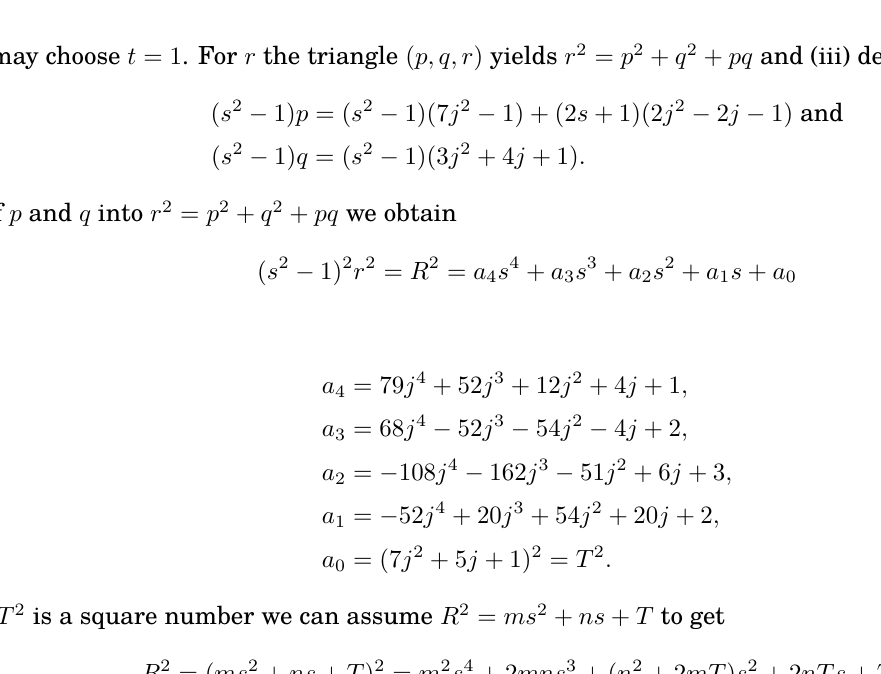
Figure 10: Icosahedron, minimum d = 159 , and its